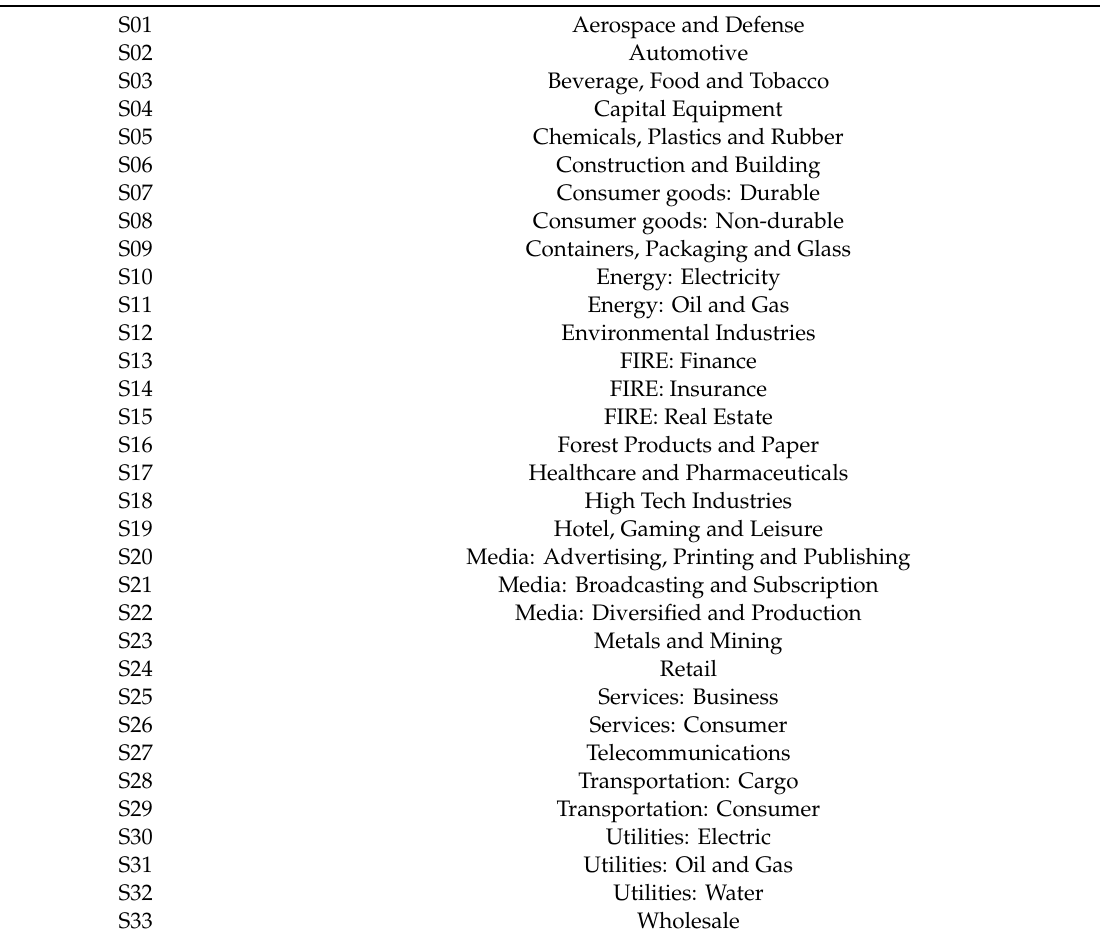
Table A1. List and numbering of non-financial corporate sectors. Source: Moody’s and